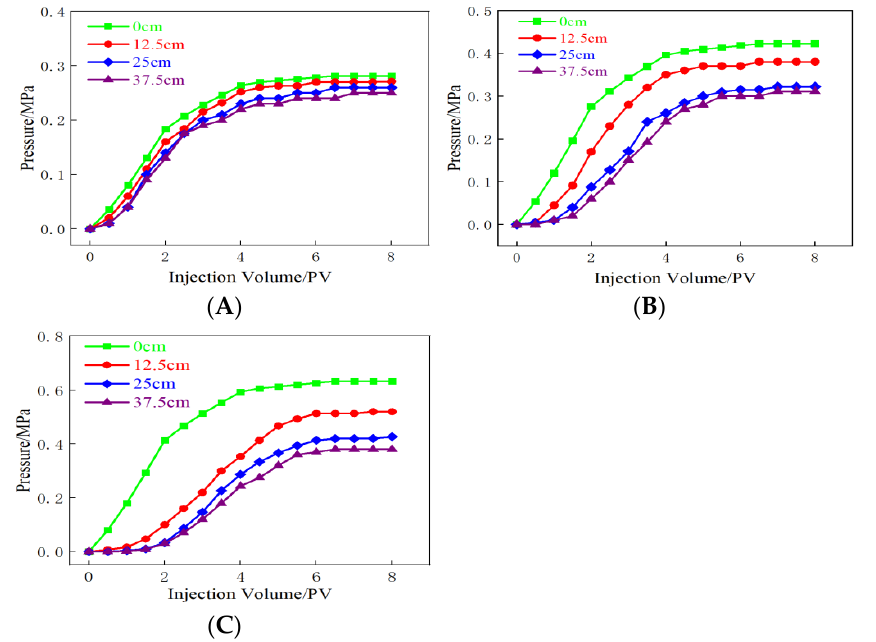
Figure 13. Injectivity of the gel system in sand-filled tubes characterized by different permeability lengths. ( A ) Permeability at 800 × 10 − 3 μ m 2 ; ( B ) permeability at 300 × 10 − 3 μ m 2 ; ( C ) permeability at 100 × 10 − 3 μ m 2 . Table 3. Diversion rates of cores recorded under conditions of varying permeability